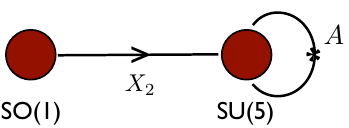
orbifold singularity. Matter (cid:12)elds follow 6 0